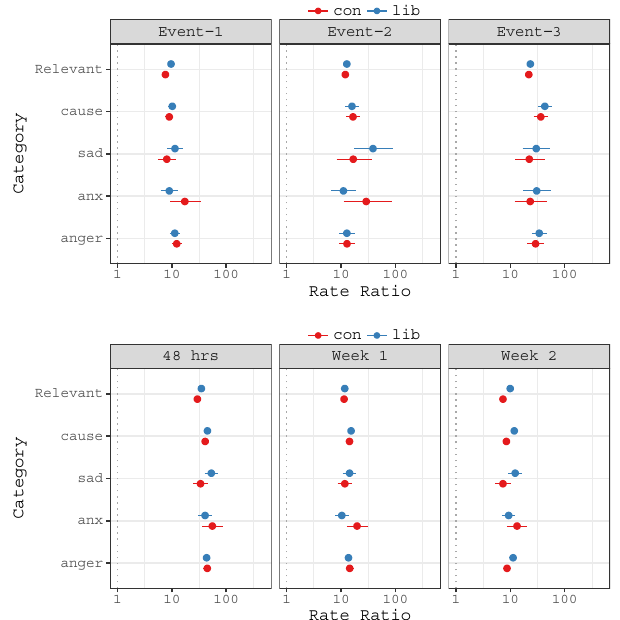
Fig. 2 Linguistic shifts across events and stages. Before-after rate ratios across events (top) and at different post-event stages